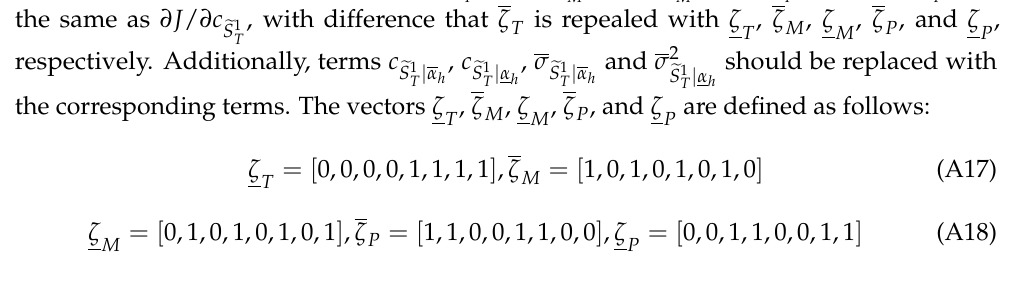
Table A1. Explaining the symbols used in this